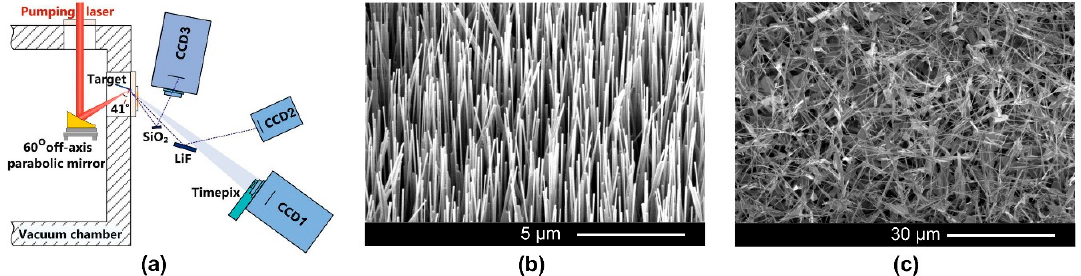
Figure 1. ( a ) the scheme of the experimental setup (not to scale). All the diagnostics (except the focal spot imaging system) are shown. The charge-coupled device (CCD3) recording the X-rays reflected from the quartz (SiO 2 ) crystal also detected signals not reflected from the crystal. Scanning electron microscope (SEM) images of the investigated targets: ( b ) the ordered nanowire (NW) target; ( c ) the disordered NW target.